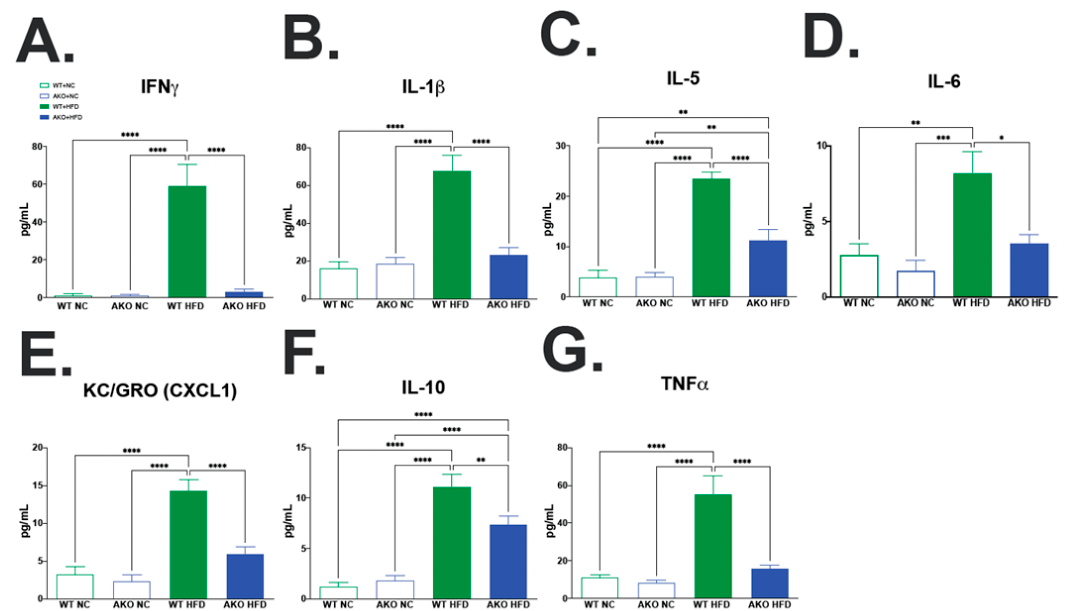
Figure 6G) the hippocampus compared to HFD-fed WT mice (Figure 6A–G).